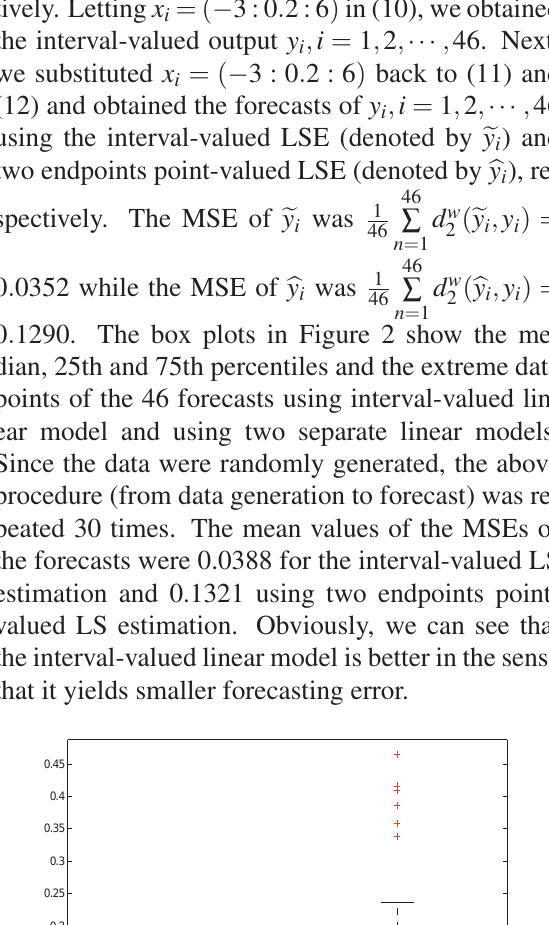
Fig. 2. Box plots of forecasts results using interval-valued linear model (left) and left- and right-endpoints point- valued linear models (right).